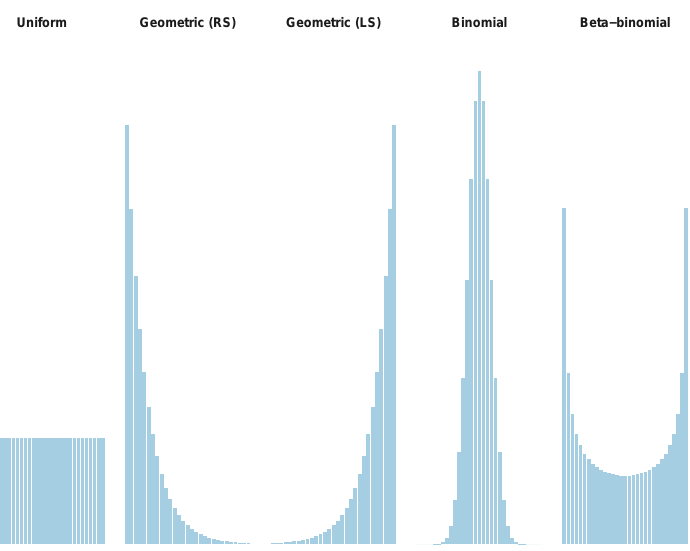
Figure 4. The five initial rod lengths distributions. From left to right: uniform, truncated right skewed geometric (geometric (RS)), truncated left skewed geometric (geometric (LS)), binomial, and